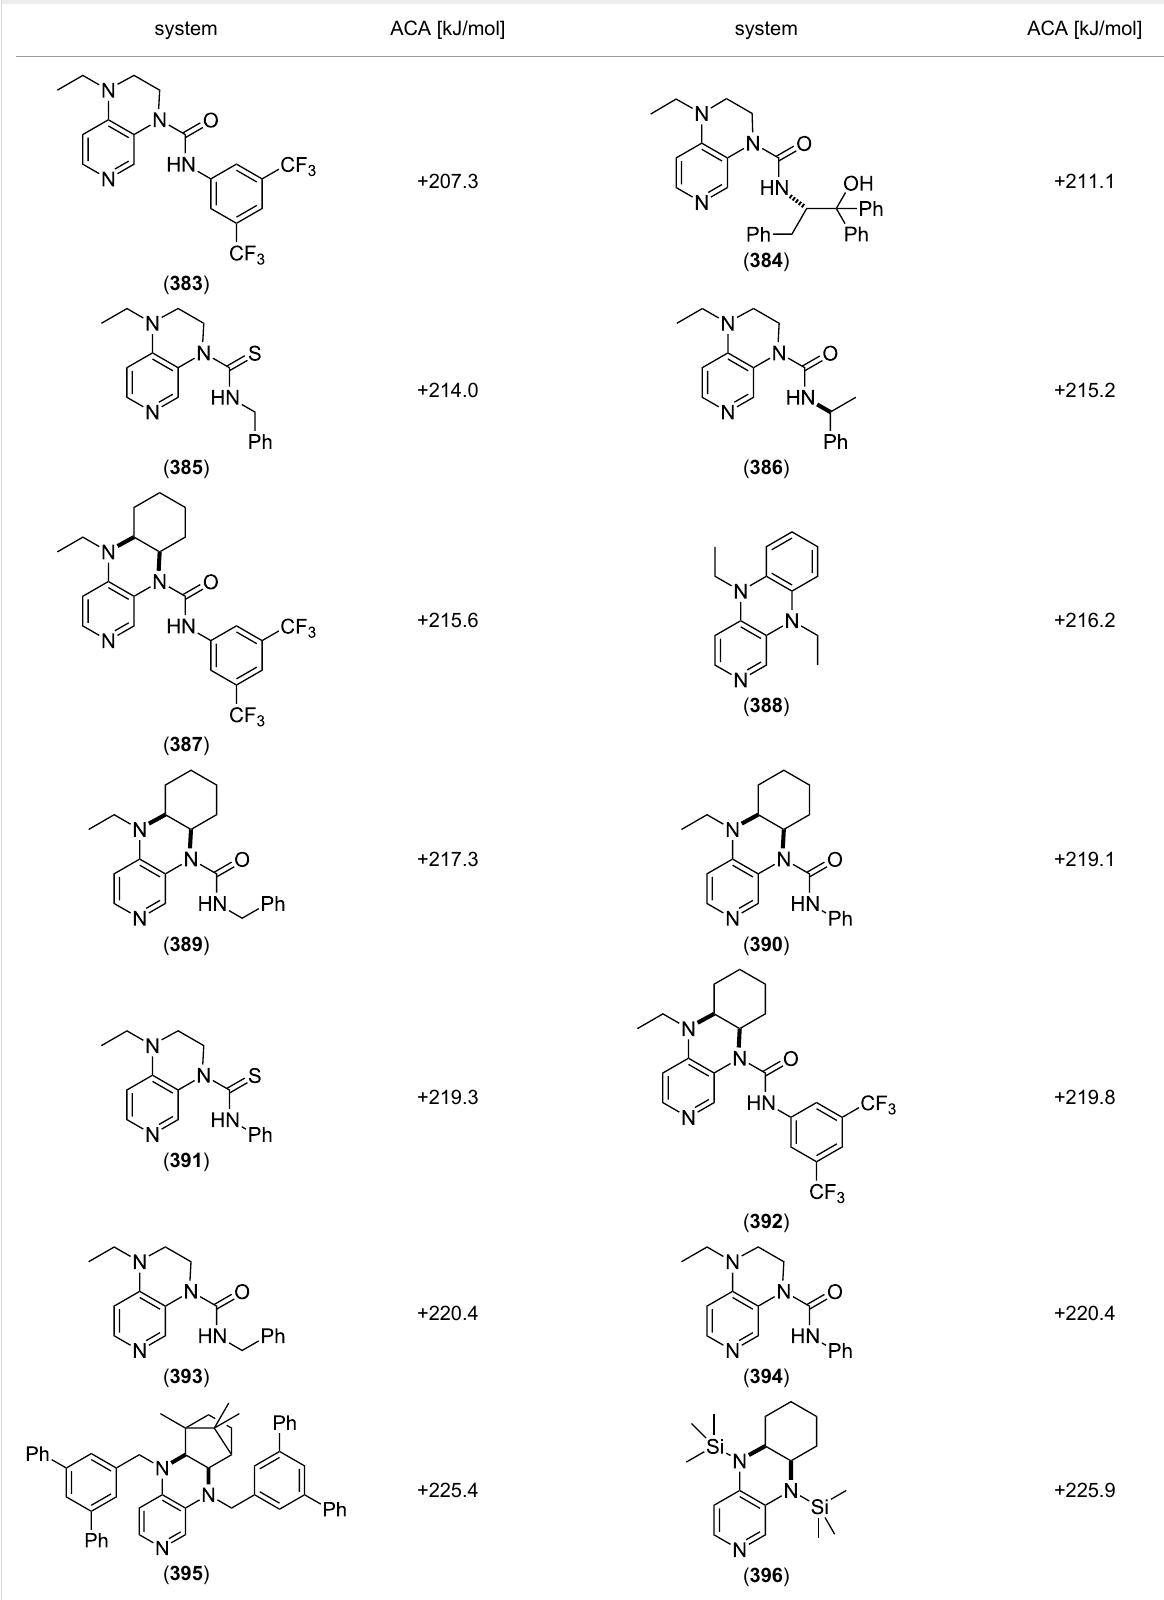
Table 14: ACA values of 3,4-diaminopyridines, ordered by increasing ACA